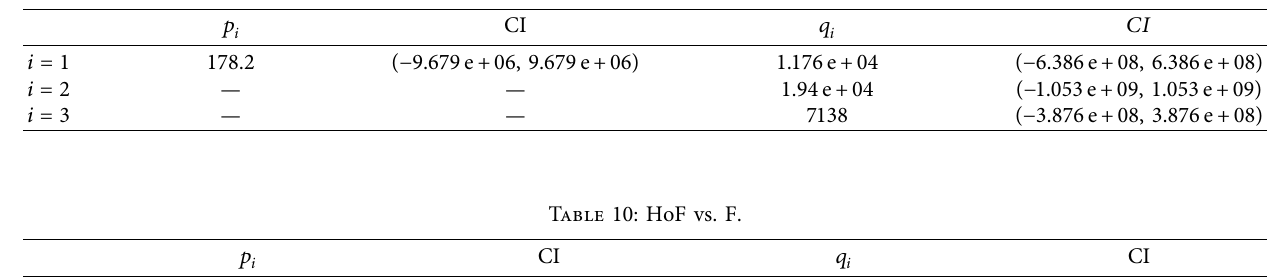
Table 9: HoF vs. HM.